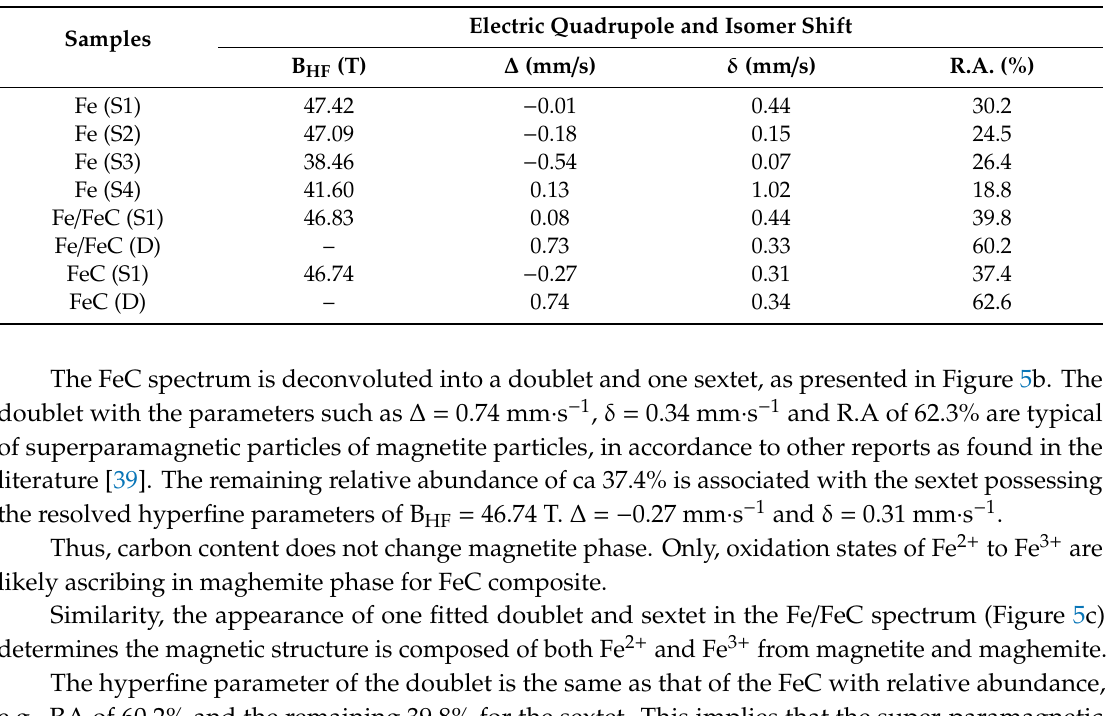
Table 3. Mössbauer parameters obtained from refinements of the spectra at 77 K. Electric quadrupole splitting ( ∆ ), isomer shift ( δ ), hyperfine magnetic field (B HF ) and Relative spectral area (R.A) parameters of the Fe-containing samples. The letter S represents the sextets in the samples.